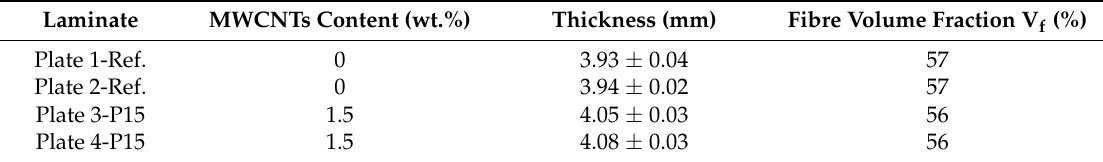
Figure 2. Infrared camera image of resin injection during infusion process. Table 1. Thickness and fibre volume fraction of produced laminates .